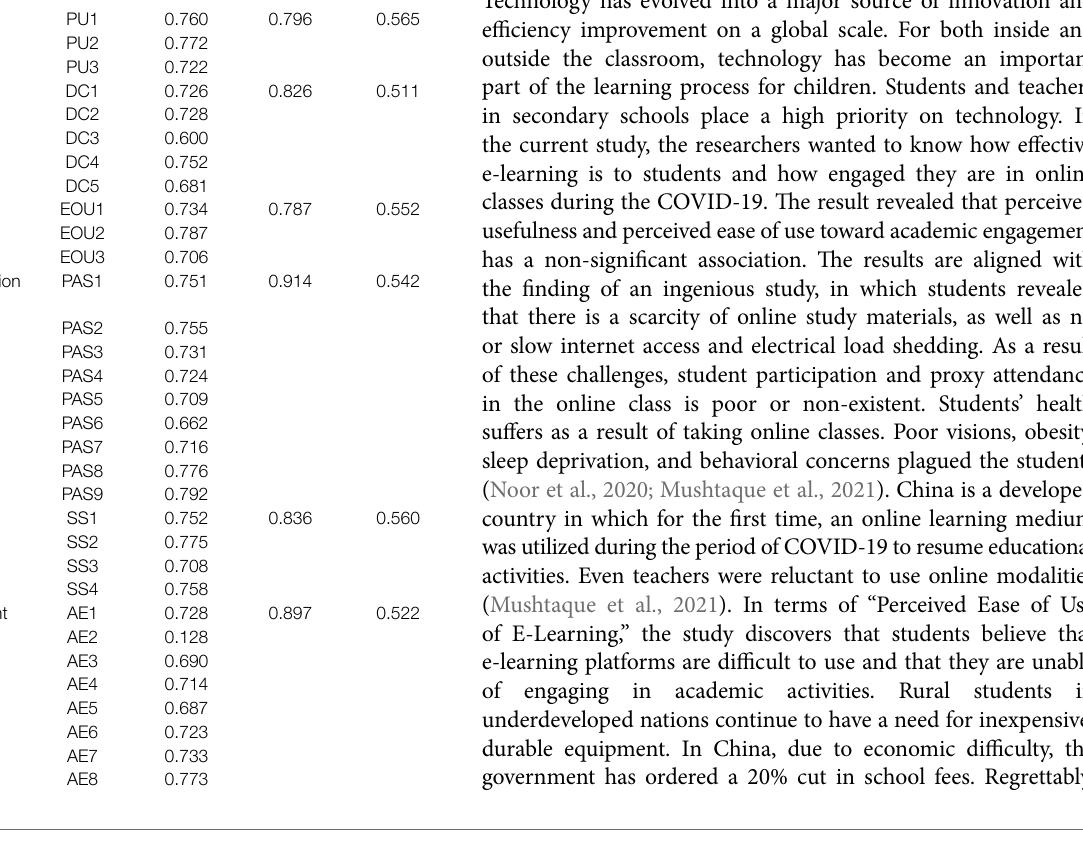
TABLE 2 | Latent variable correlations and square roots of average variance extracted